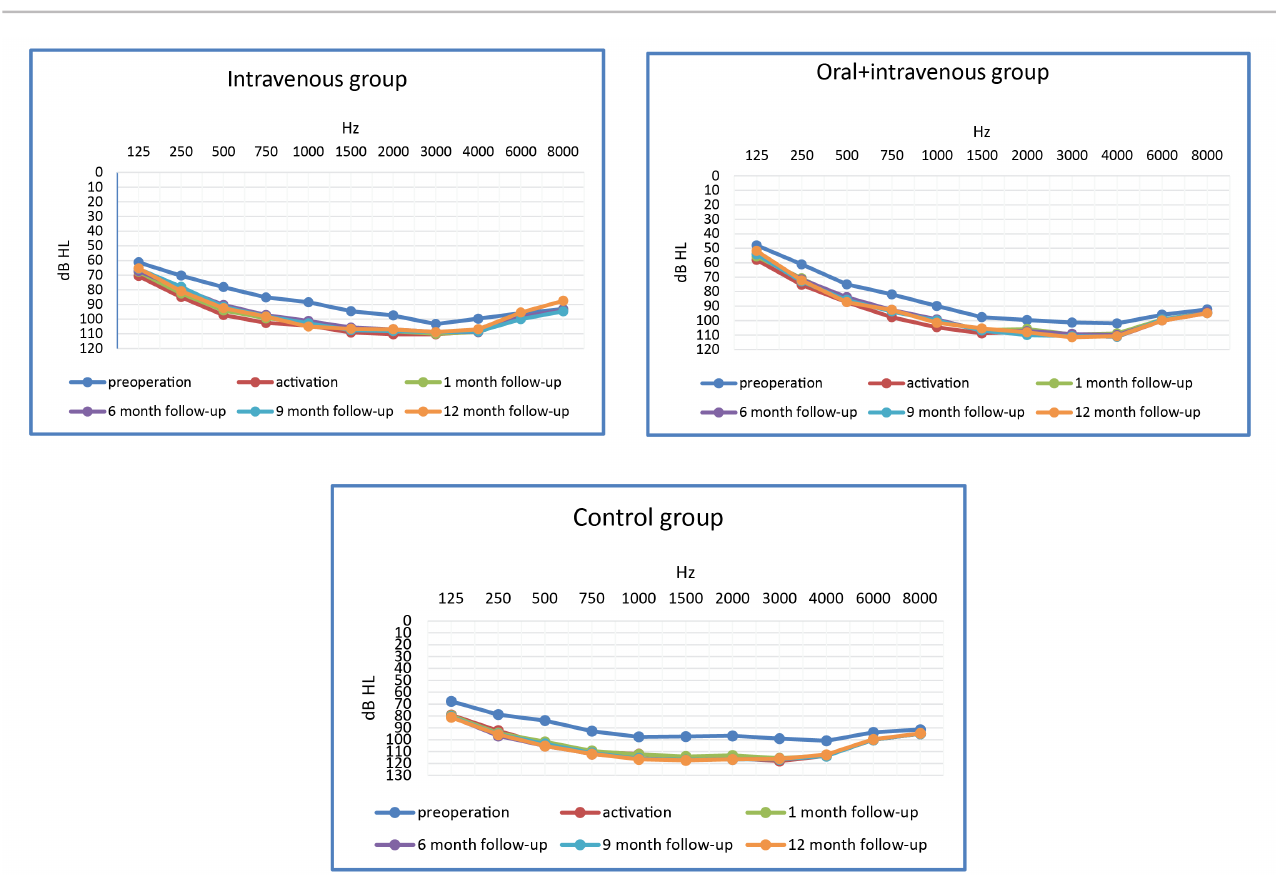
FIGURE 4 - Mean hearing thresholds of patients with standard steroid therapy (IV group), patients with prolonged steroid therapy (oral and IV group), and control patients at six time points: the pre-operative period, upon activation, and at 1, 6, 9, and 12